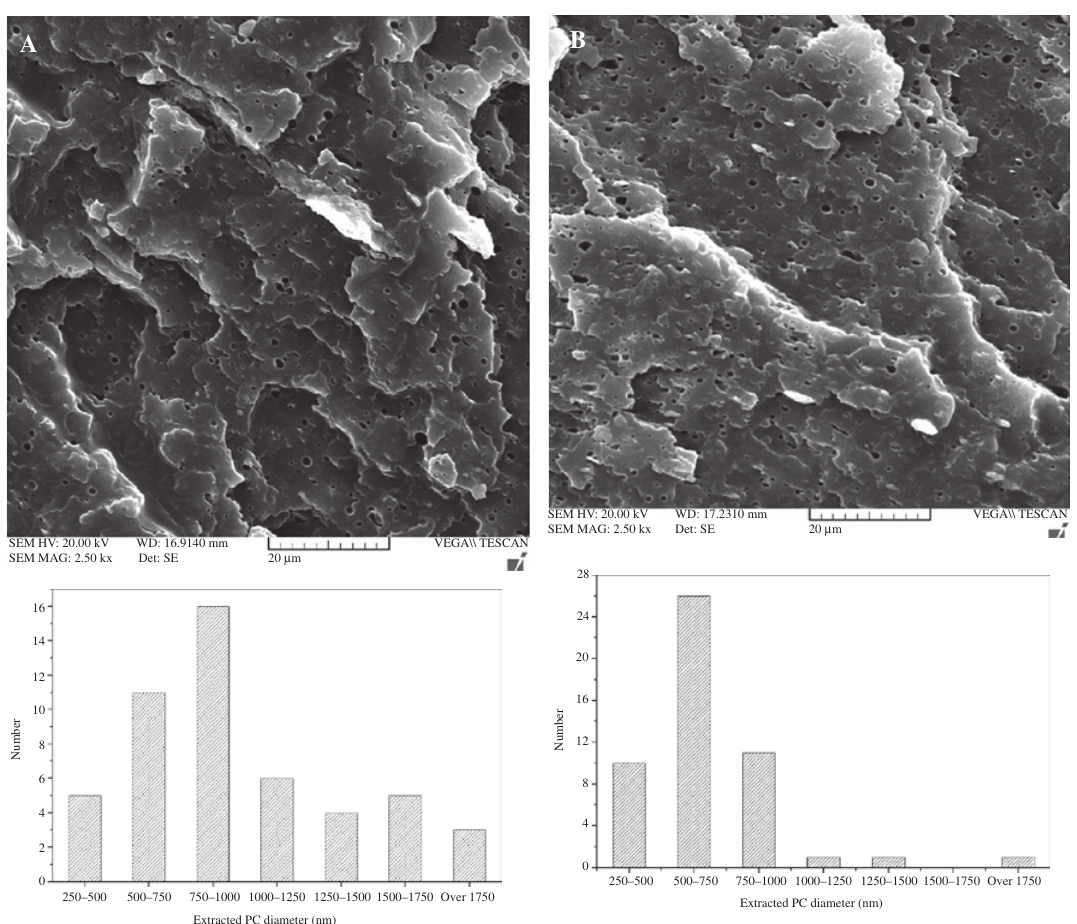
Figure 7: SEM micrographs of cryofractured surfaces of PP/PC nanocomposites after PC extraction: (A) Nanocomposite with 10 wt% PC and 5 wt% NC, (B) nanocomposite with 10 wt% PC and 10 wt% NC, (C) nanocomposite with 30 wt% PC and 5 wt% NC.